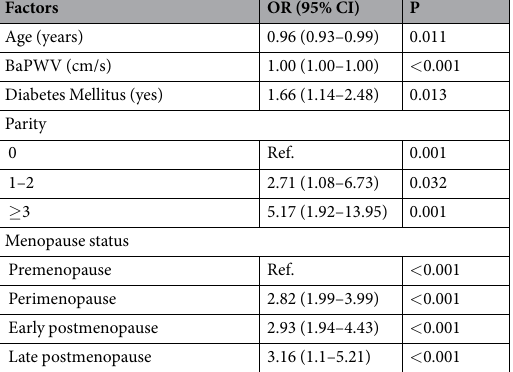
Table 2. Independent factors for sleep disorder by logistic regression. Covariates: BMI, WHR, SBP, DBP, PP, hypertension, diabetes mellitus, TG, TC, HDL, LDL, FBG, menopause, income, employment status, parity. OR, Odds ratio; CI, confidential interval. Only displayed p < 0.05